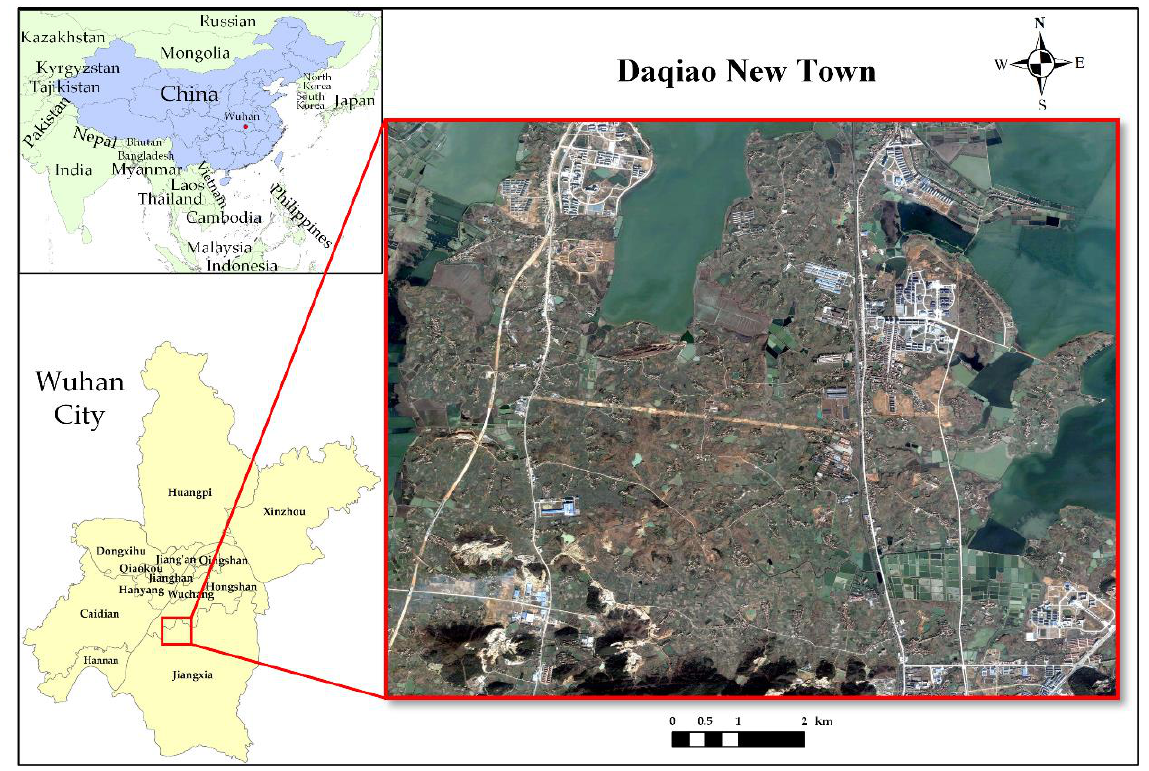
Figure 1. The location of the study area. The right image is the Google Earth image of Daqiao New Town. The top-left image is the scaled map of China in the international context, and the bottom-left corner is Wuhan.